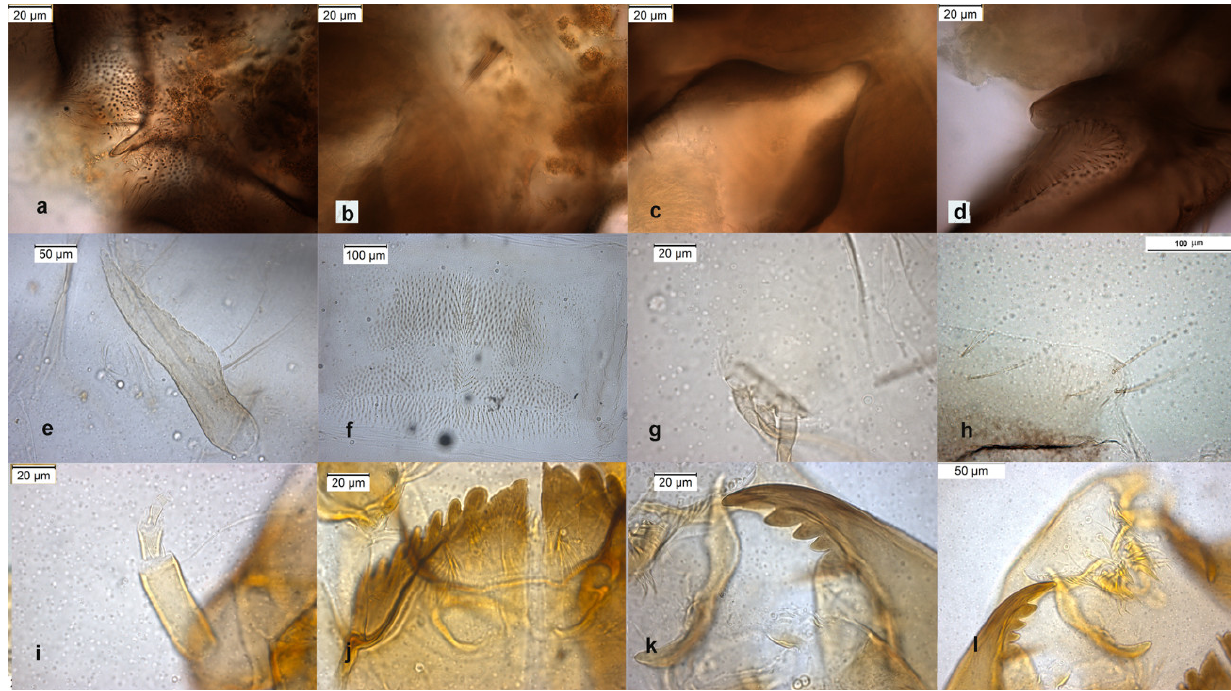
Figure 8. Morphological characters of O. rubicundus adult male: ( a ) anal point; ( b ) virga; ( c ) superior volsella; ( d ) inferior volsella; pupal exuvia: ( e ) thoracic horn, ( f ) tergite IV; ( g ) sternite-IV; ( h ) taeniate extensions; larva: ( i ) antenna; ( j ) mentum; ( k ) mandible; ( l ) labrum.